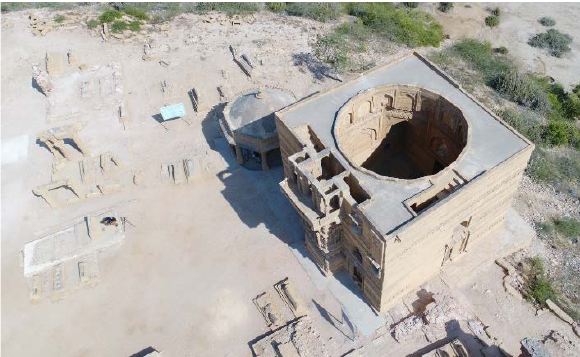
Figure 5. The highly significant tomb of Jam Nizam Al Din